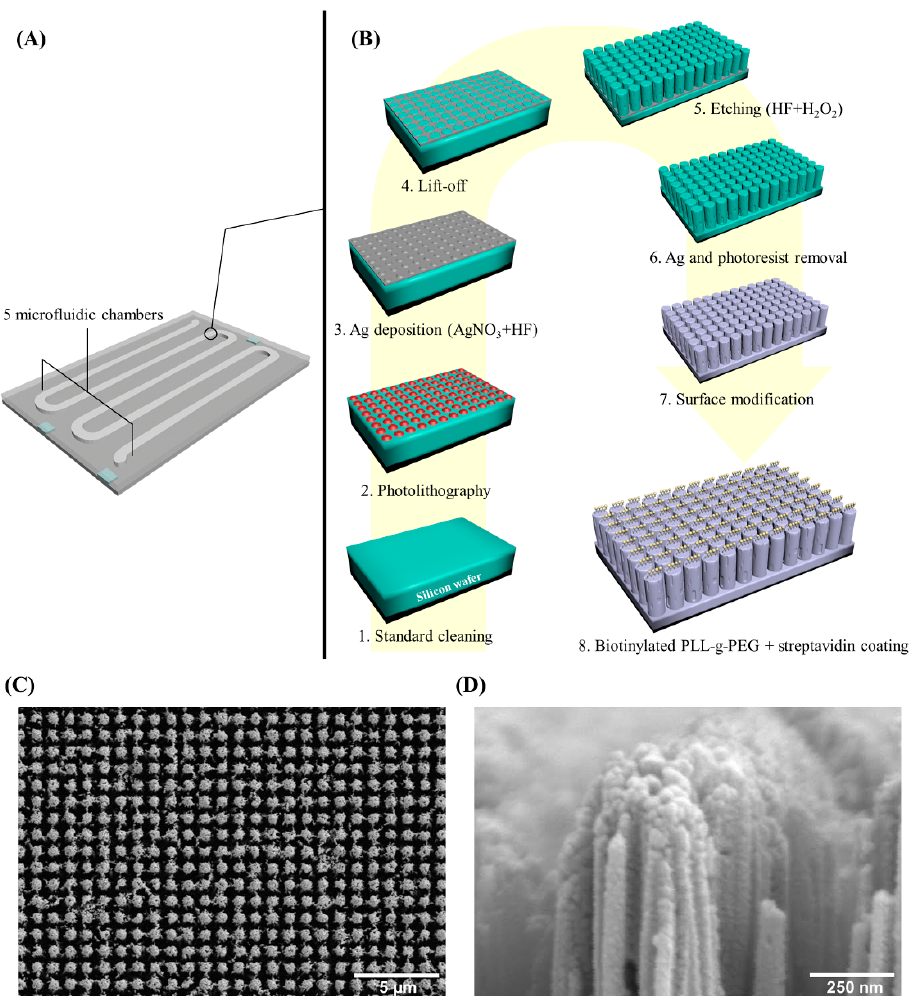
Figure 1. The silicon-based microfluidic Coral Chip. ( A ) An exemplified Coral Chip with 5 microfluidic chambers. ( B ) The manufacturing follow chart of the Coral Chip chamber surface: 1. standard cleaning, 2. photolithography, 3. Ag deposition, 4. liftoff, 5. etching, 6. Ag and photoresist